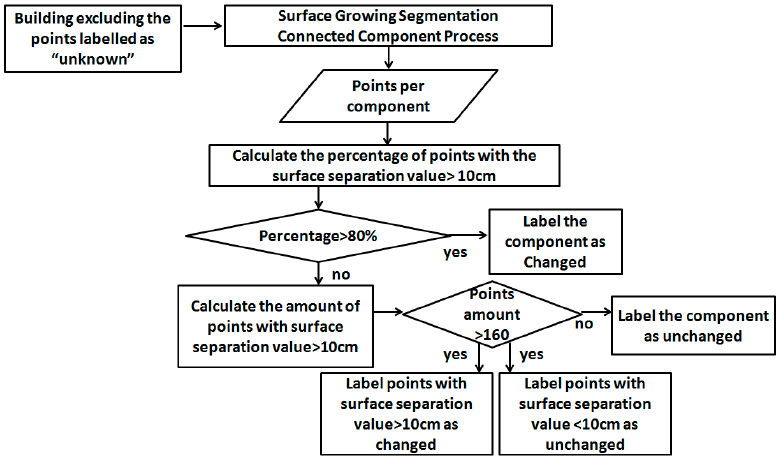
Figure 5. Identification of changed and unchanged points using a decision-tree.